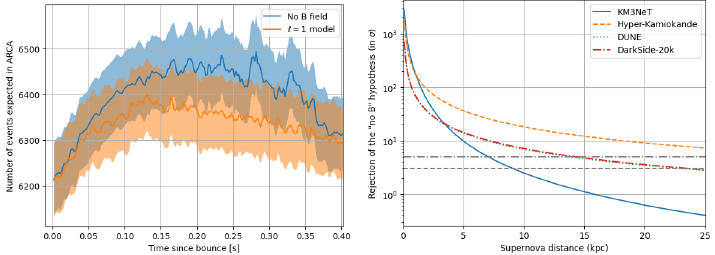
Figure 3. Left: Neutrino rates expected at KM3NeT-ARCA for the rotating progenitors simulated in [5]. Right: Significance of the di ff erence between the “no magnetic field” and the dipolar models as a function of the CCSN